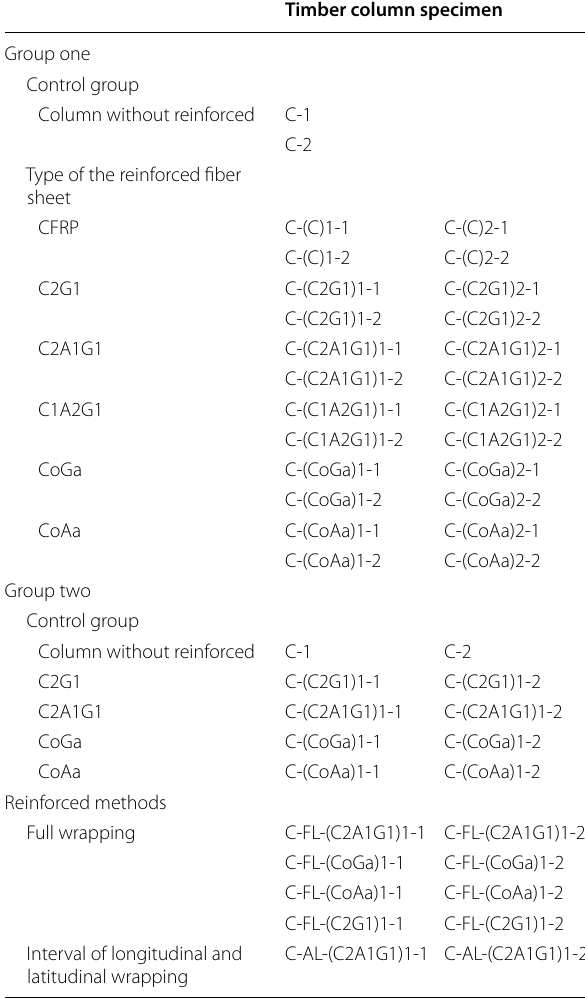
Table 5 Timber columns specimens for compression